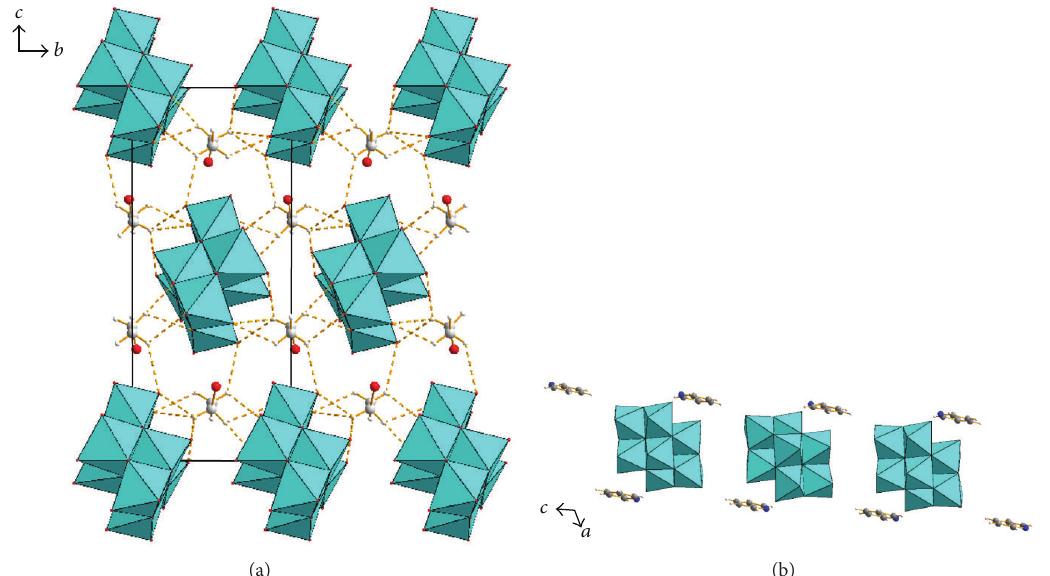
Figure 4: (a) Molecular arrangements in the inorganic layers of C 16 py-H 2 Mo 8 . The short contacts including C–H ⋅⋅⋅ O hydrogen bonds are represented in broken lines. (b) Molecular arrangements of C 16 py-H 2 Mo 8 at the interface between the 𝛽 -H 2 Mo 8 inorganic and C 16 py organic layers. The hexadecyl groups and ethanol molecules are omitted for clarity.